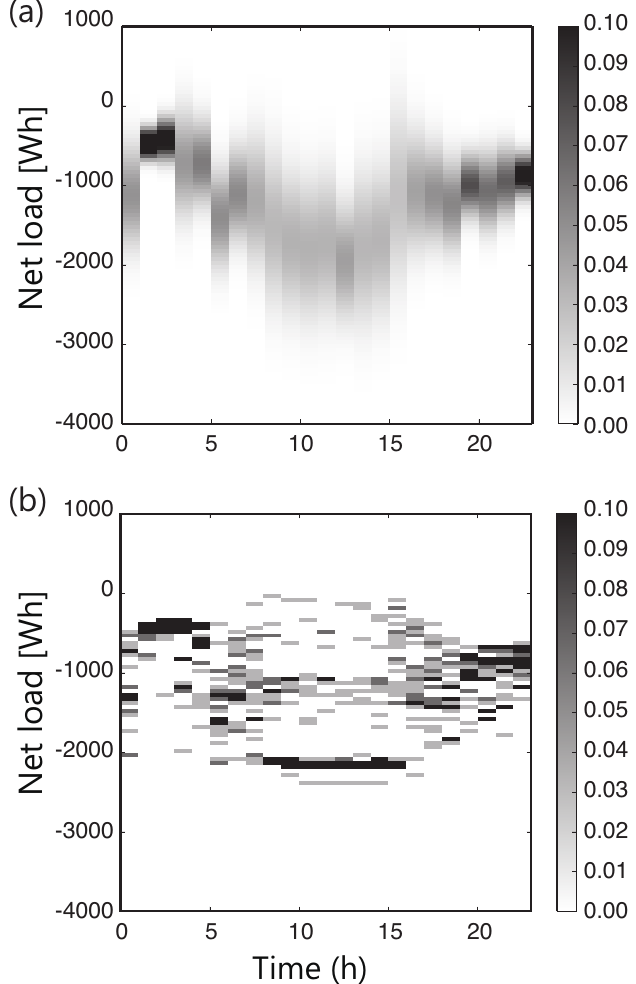
Figure 4. Prediction probability distributions of the efficient load over time using the normal